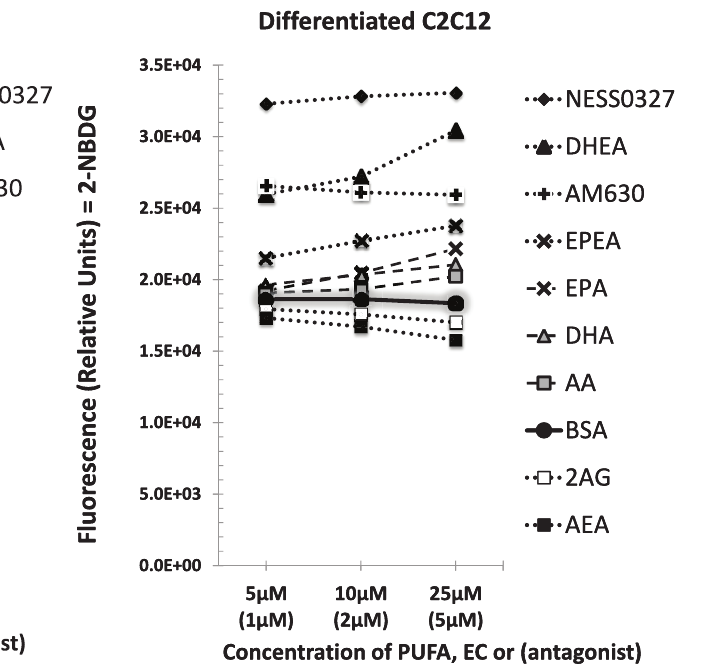
FIGURE 3 | Glucose uptake analysis of proliferating and differentiated C2C12 myoblast cultures treated with either three concentrations (5, 10, or 25 μ M) of PUFA (AA, EPA, or DHA) or endocannabinoid (AEA, 2-AG, EPEA or DHEA) or with three concentrations (1, 2, or 5 μ M) of cannabinoid receptor antagonist (AM630 or NESS0327) for 24h. Values shown are means of 3 experiments performed in triplicate. In proliferating cells compared to the BSA vehicle control (gray shaded